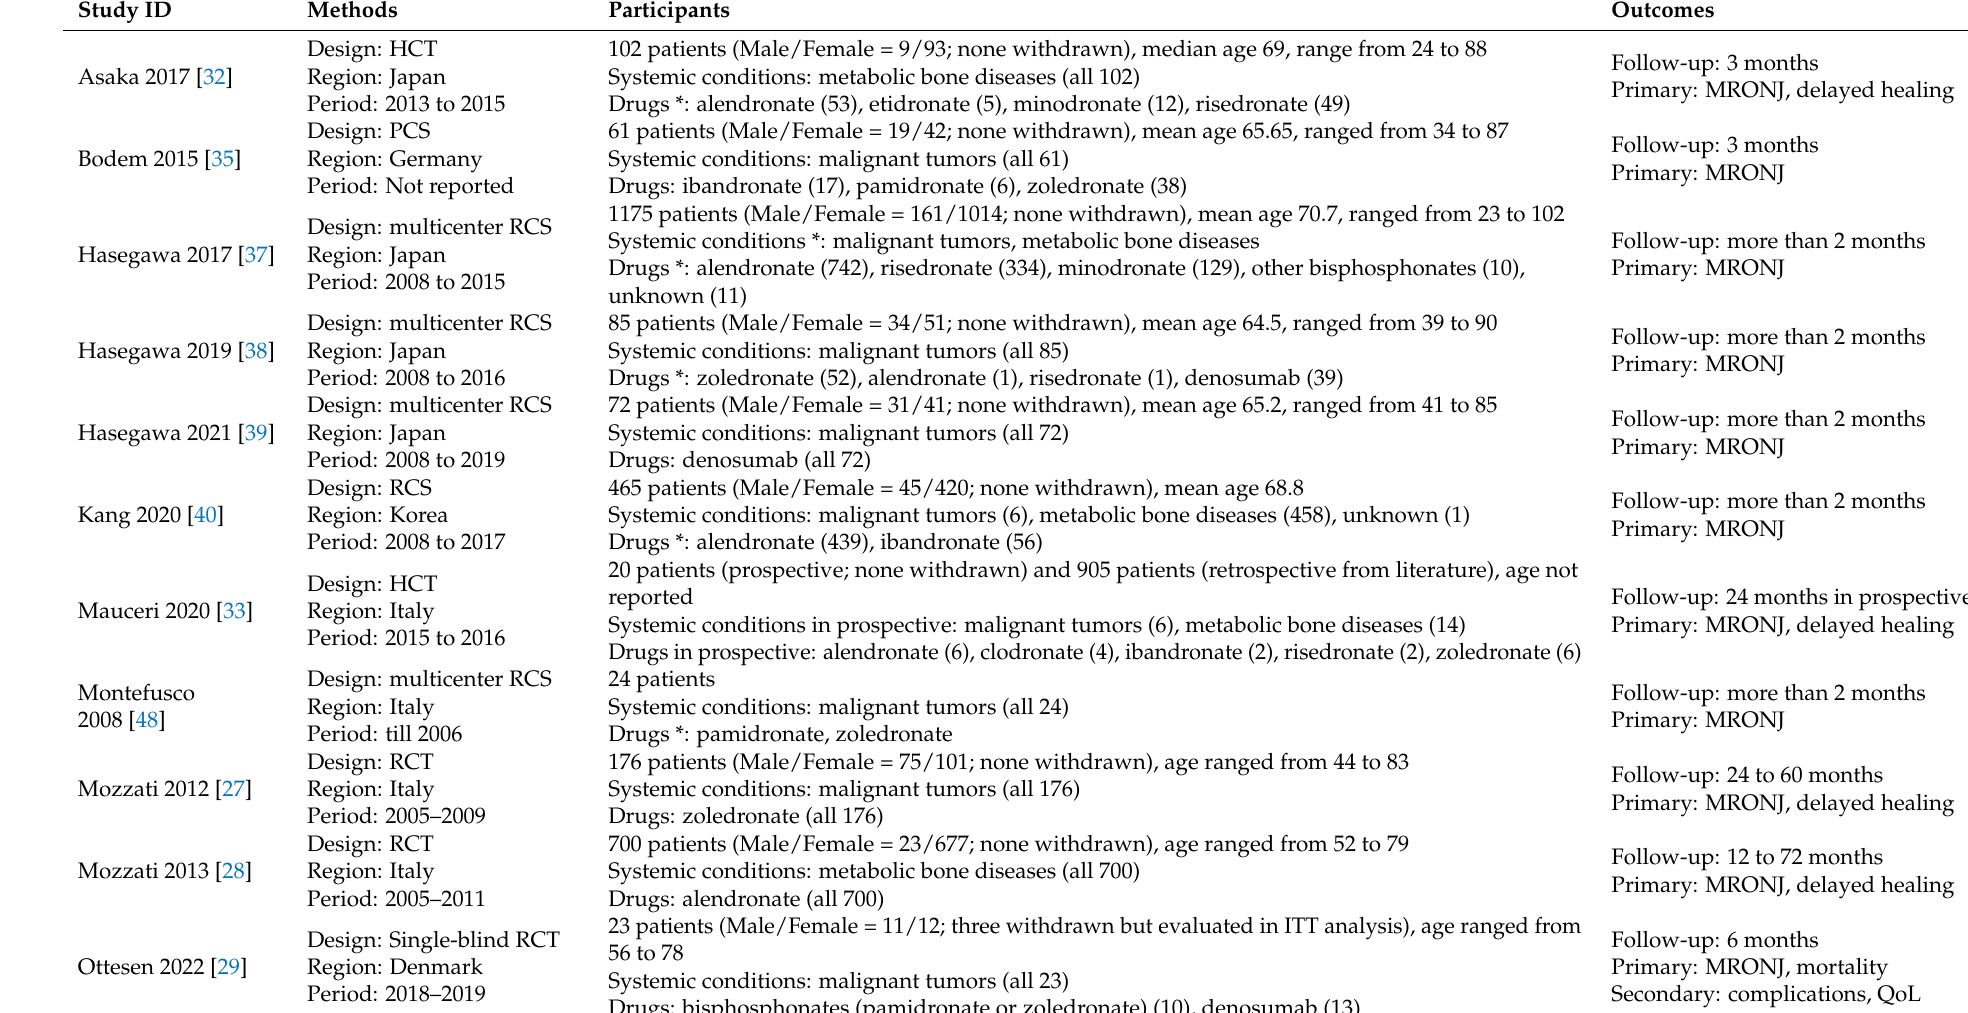
Table 4. Characteristics of included primary